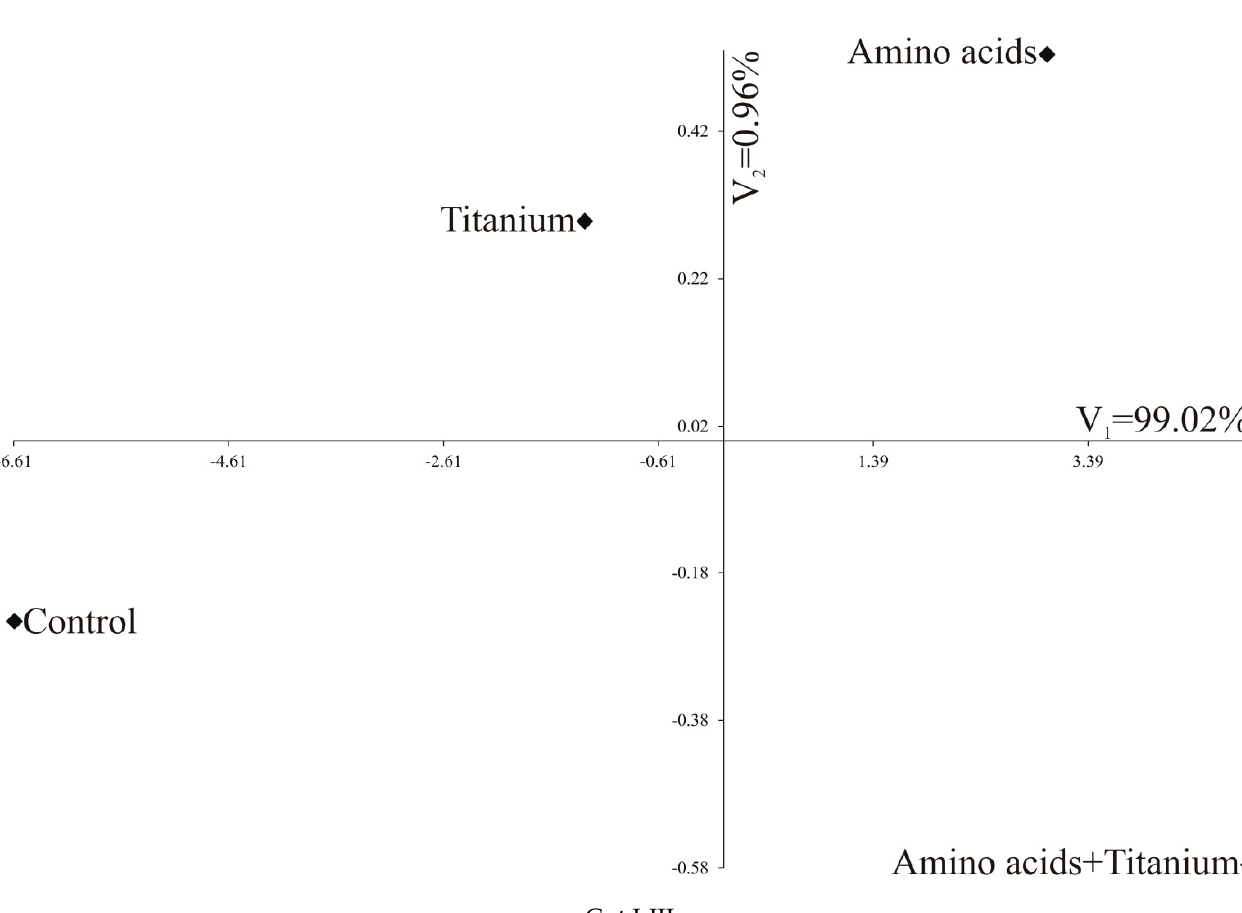
Table 4. The values of the Mahalanobis distances for all pairs of biostimulant treatments in cut I, cut II, cut III, and all three cuts jointly. Biostimulant Cut